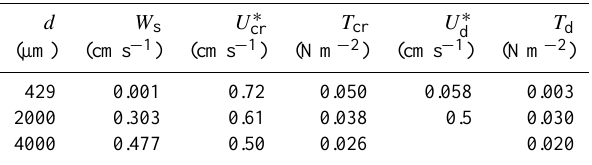
Table 1. OMA characteristic data used in the model simulations: aggregate size d (µm); settling velocity W s (cms − 1 ); critical and depositional velocities U ∗ cr and U ∗ (cms − 1 ); critical and deposi- d tional bottom shear stresses T cr and T d (Nm − 2 ) (Thomsen et al., 2002; de Jesus Mendes and Thomsen,